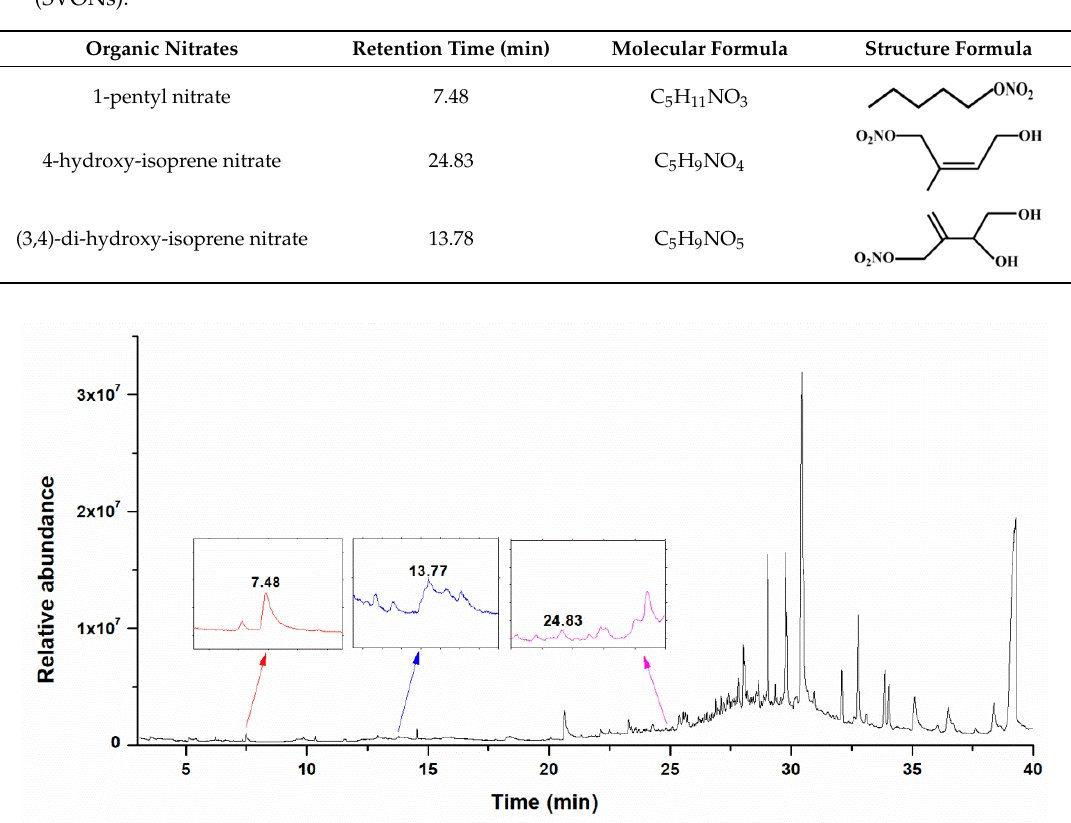
Table 1. Retention time, molecular formulae, and structures of the three semivolatile organic nitrates (SVONs).